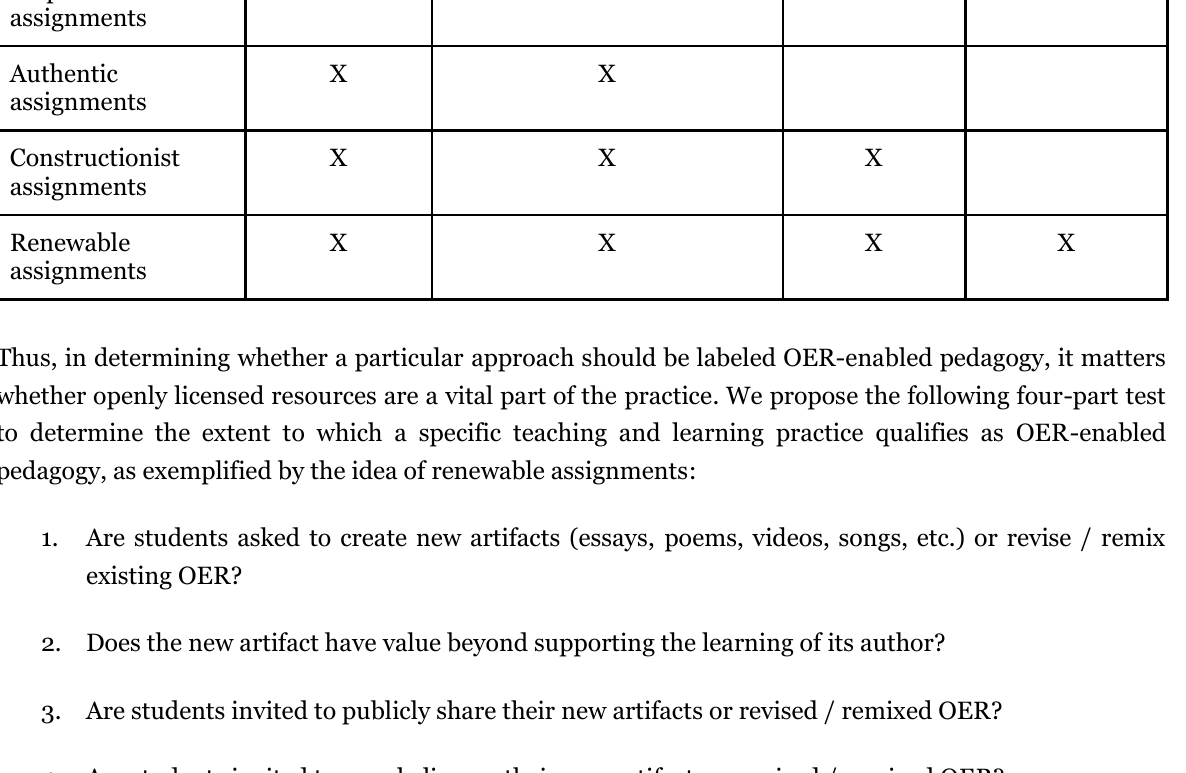
Student The artifact has value beyond creates an supporting its creator’s artifact learning